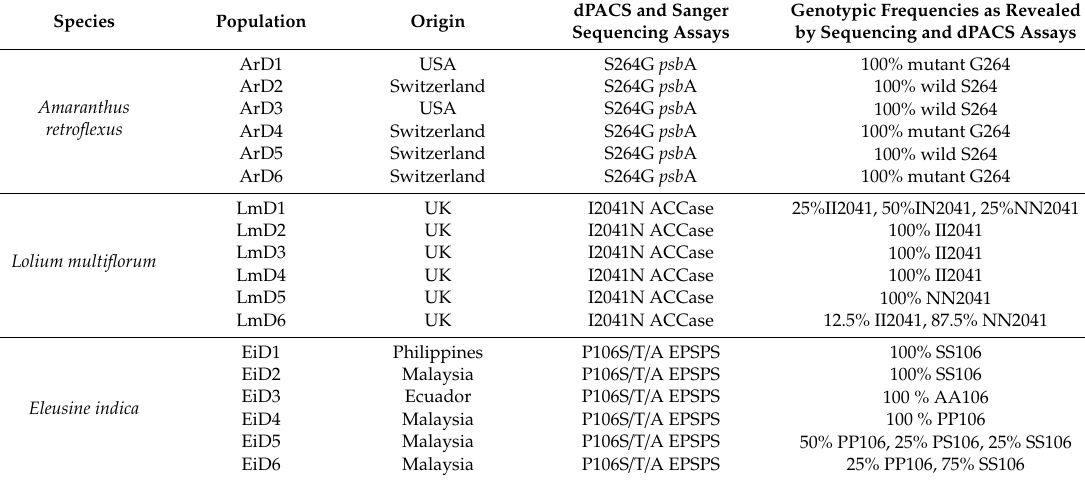
Table 1. Species and populations used to validate the three derived Polymorphic Amplified Cleaved Sequence’ (dPACS) assays and corresponding Sanger sequencing and dPACS results. Species Population Origin